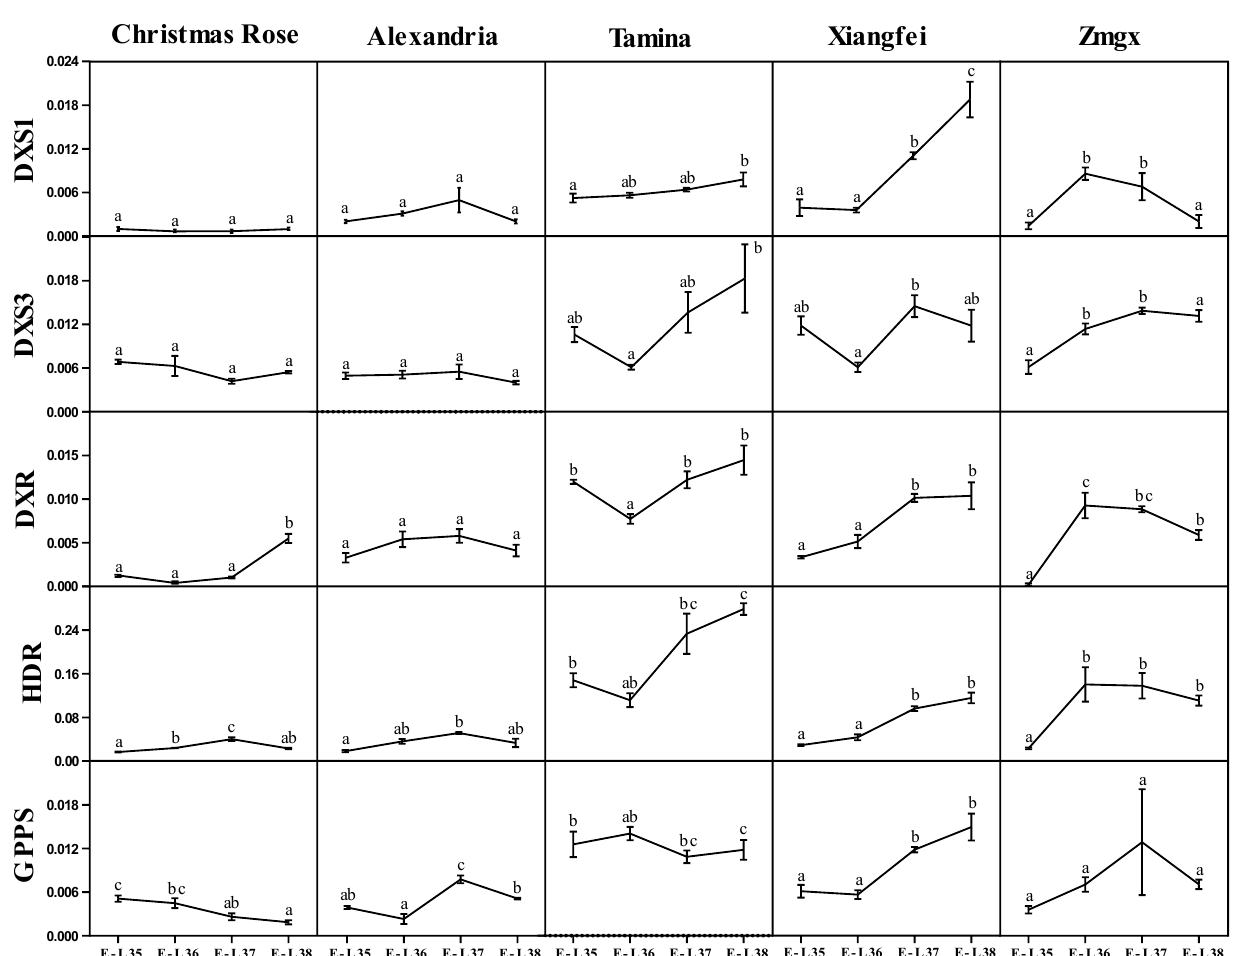
Figure 3. Transcript levels of critical genes of the MEP pathway during the development of berries in different table grape varieties in 2014. Values with different letters (a–c) on a row were significantly different based on Tukey’s multiple range test ( p < 0.05). “Zmgx” represents “Zaomeiguixiang”,